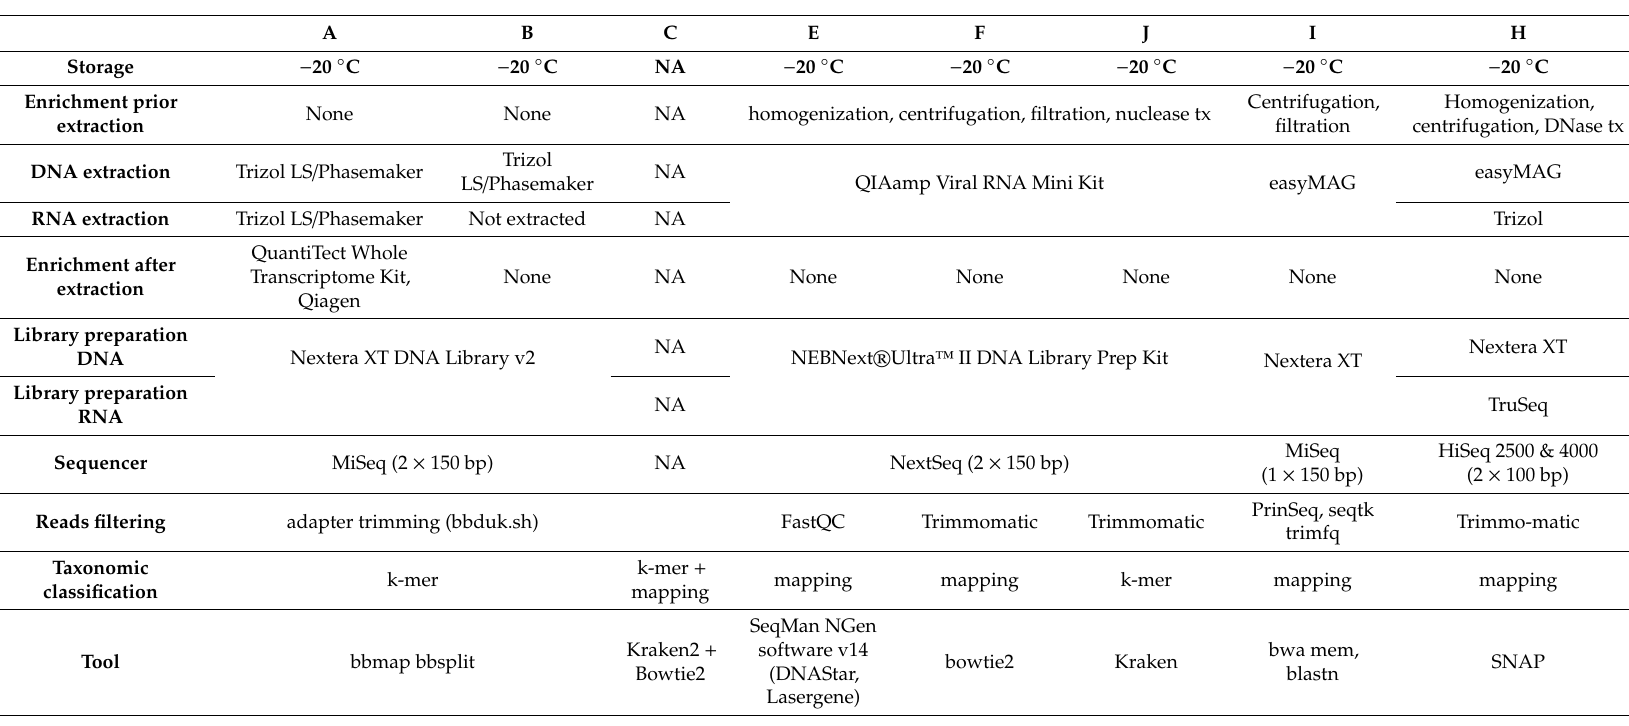
Table 3. Summary of the pipeline methodologies (tx: